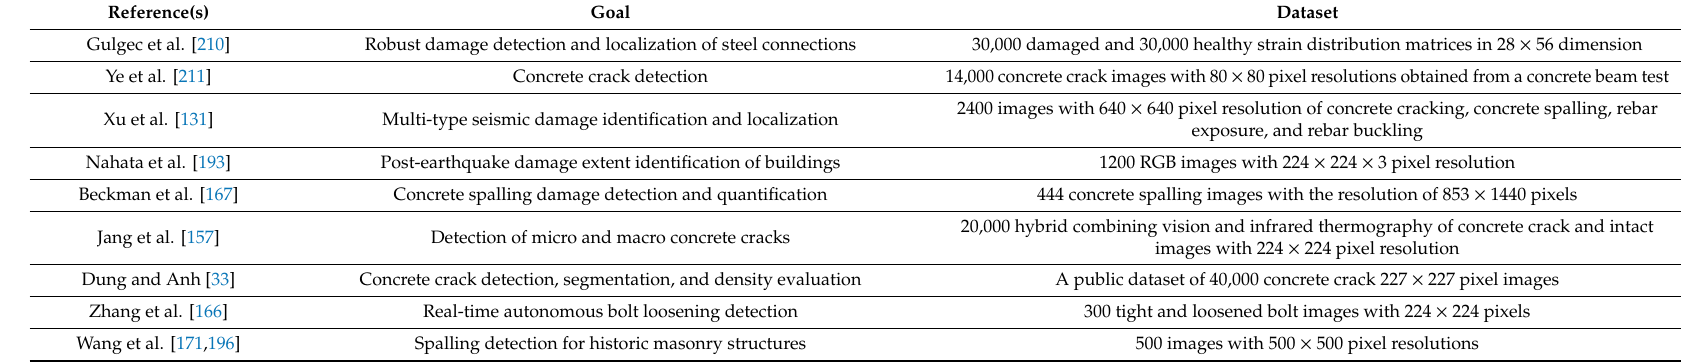
Table 3. Examples of vision-based datasets for DL-based